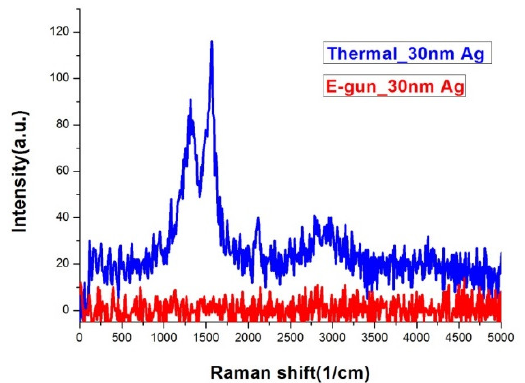
Figure 5. Raman spectra of silver films deposited by thermal and E-gun evaporation. The exposure time was 10 seconds.